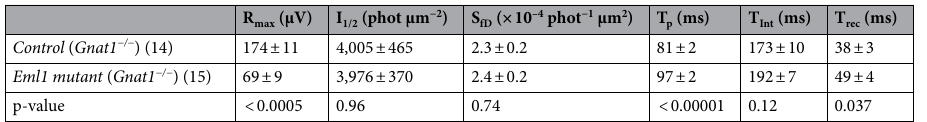
Table 3. Cone ex-vivo ERG analysis parameters. R max , saturated response amplitude measured at the plateau. I 1/2 , intensity required to produce half of the saturated response. S fD , dark-adapted sensitivity. T p , time to peak of a dim flash response. T int , integration time of the response. T rec , recovery time constant during response shut off. All values are given as Mean ±